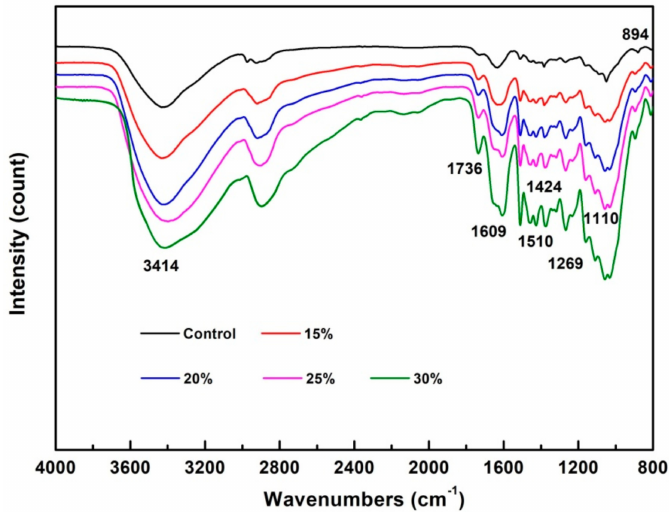
Figure 7. FTIR spectra of the control and PF modified wood.